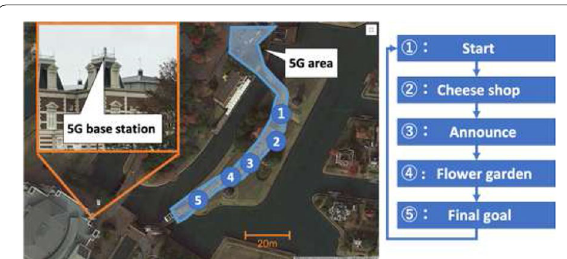
Fig. 27 Environment for experiments with the 5G network system. The blue area describes the 5G area, and the window at top left shows one of the base stations of 5G